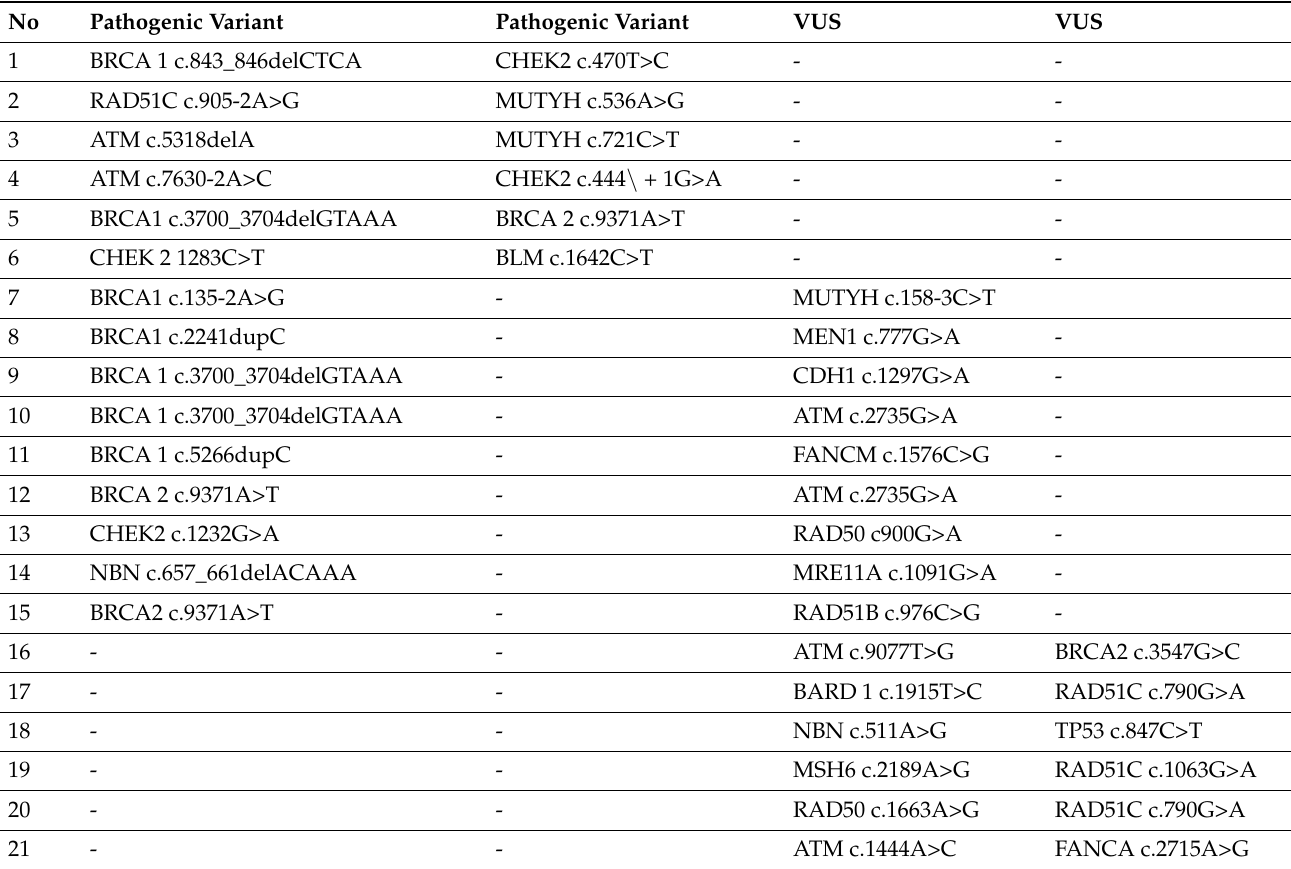
Table 5. Overlapping mutations registry of the study group